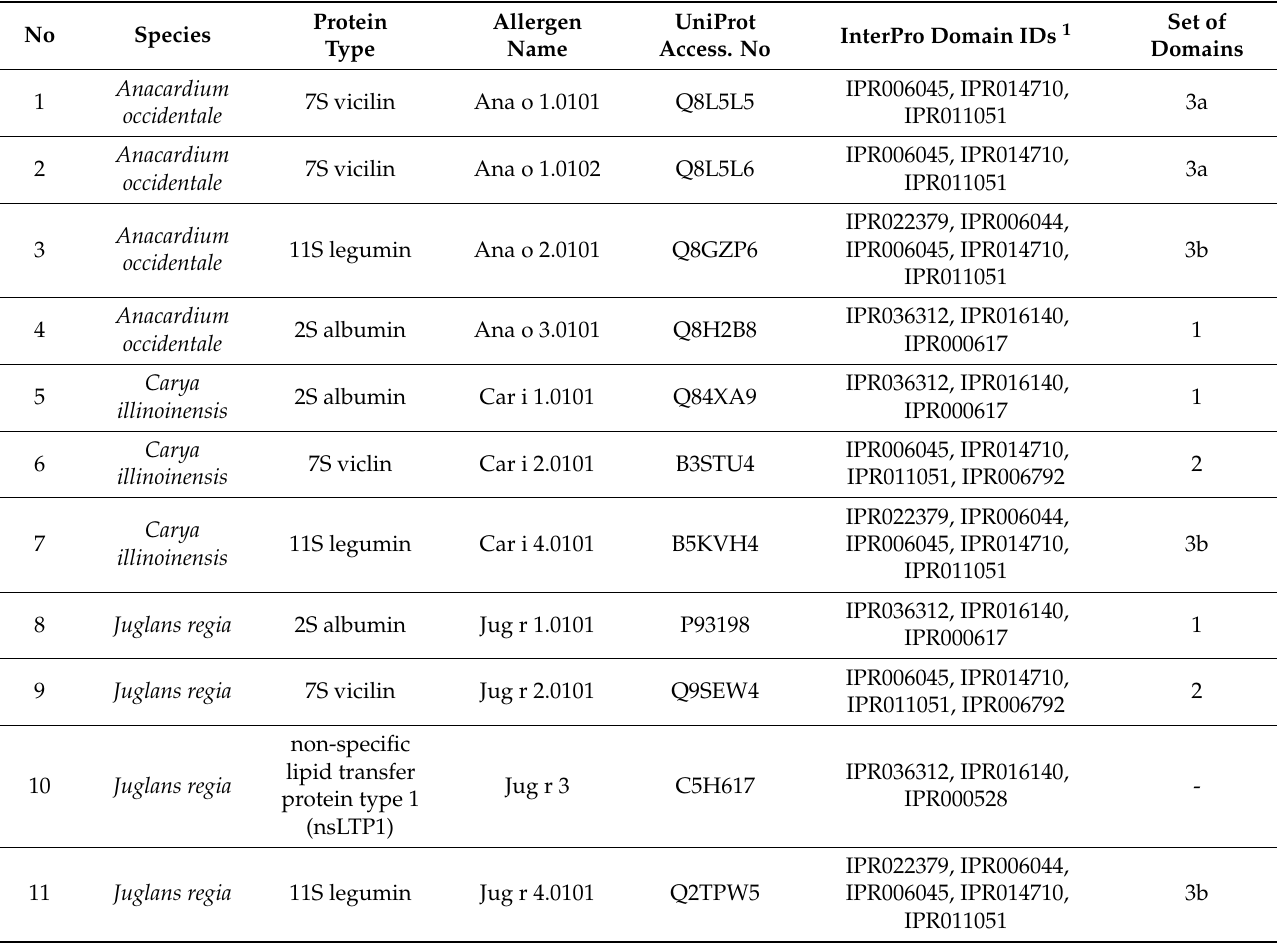
Table 1. List of allergenic proteins submitted to in silico